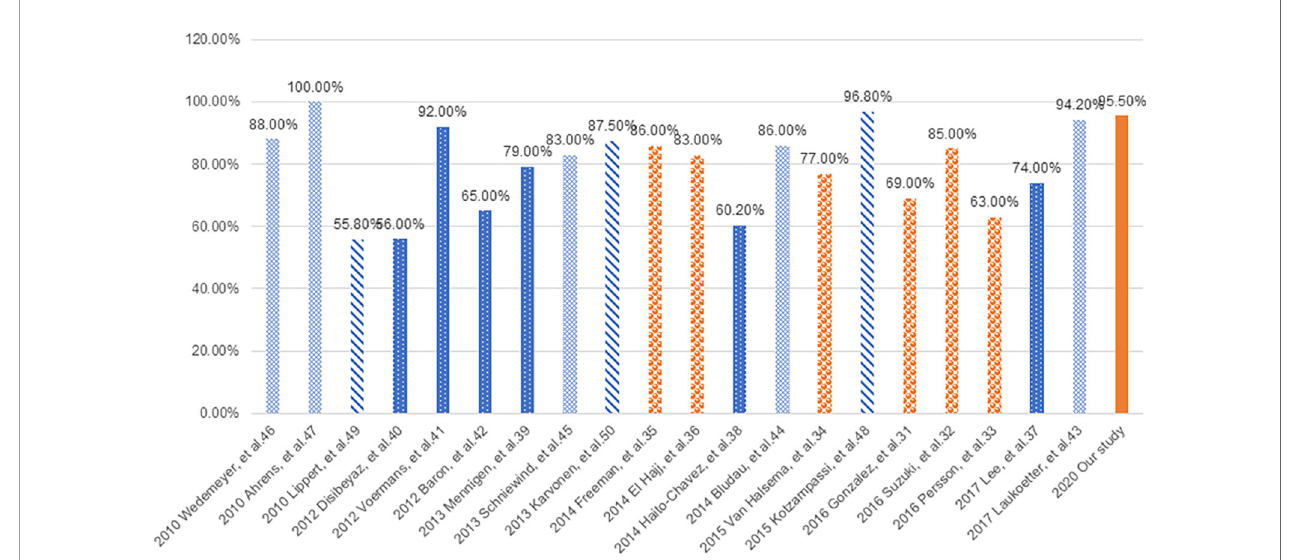
FIGURE 5 | Healing rates of EAL about part of previous